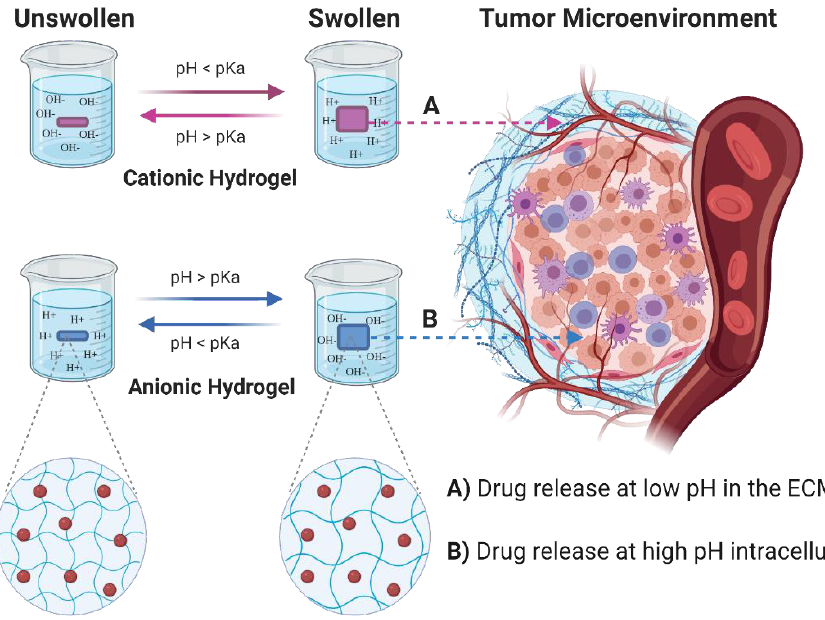
Figure 2. Schematic representation of pH-sensitive hydrogels swelling. Swelling of the hydrogel occurs via ionization of the pendant groups with consequent increase hydrophilic nature of the polymer chains and electrostatic chain repulsion. ECM—extracellular matrix, H + —Hydrogen ions, OH − —Hydroxide ions. The red circles represent the drugs loaded in the hydrogels. Created with BioRender.com (accessed on 15 January 2021).